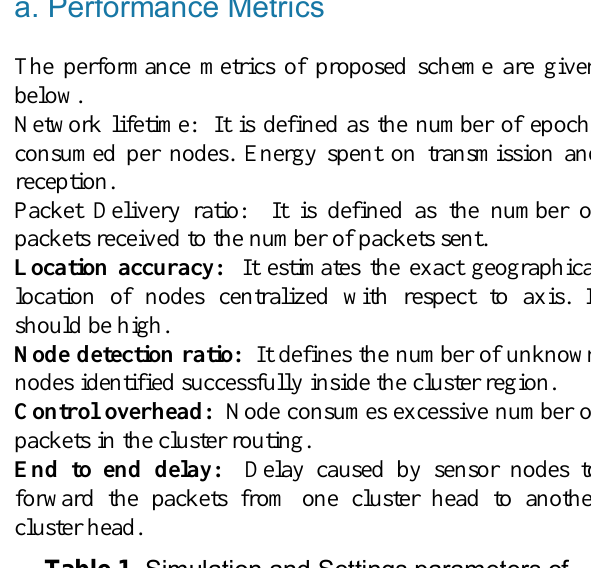
Add the field i.e. reliability,